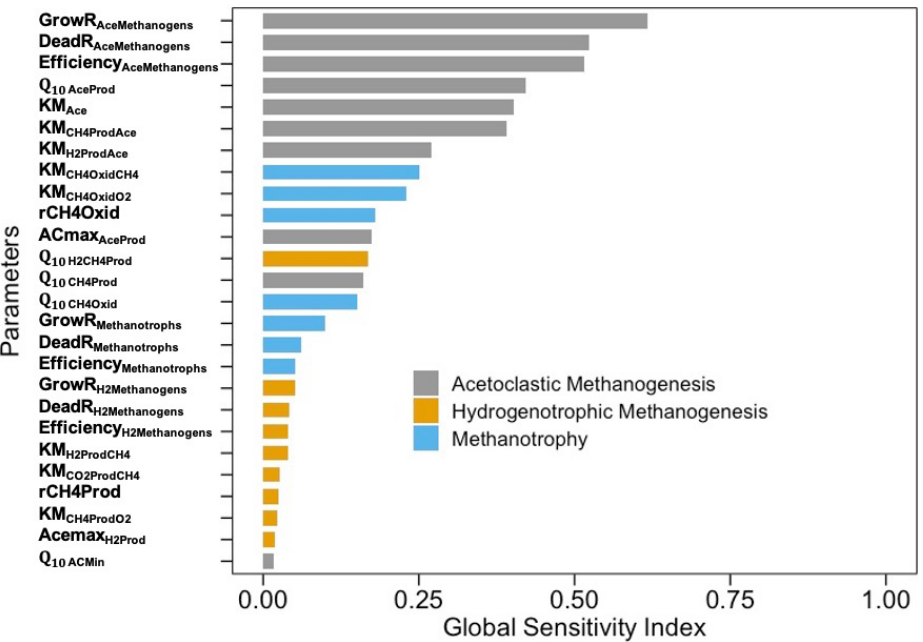
Figure 8. Global sensitivity indices of M3D-DAMM model parameters (defined in Table 1). Gray, yellow, and blue colors represent param- eters for aceticlastic methanogenesis, hydrogenotrophic methanogenesis, and methanotrophy,